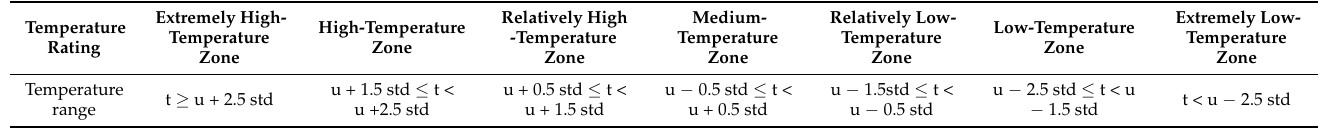
Table 2. Classification of